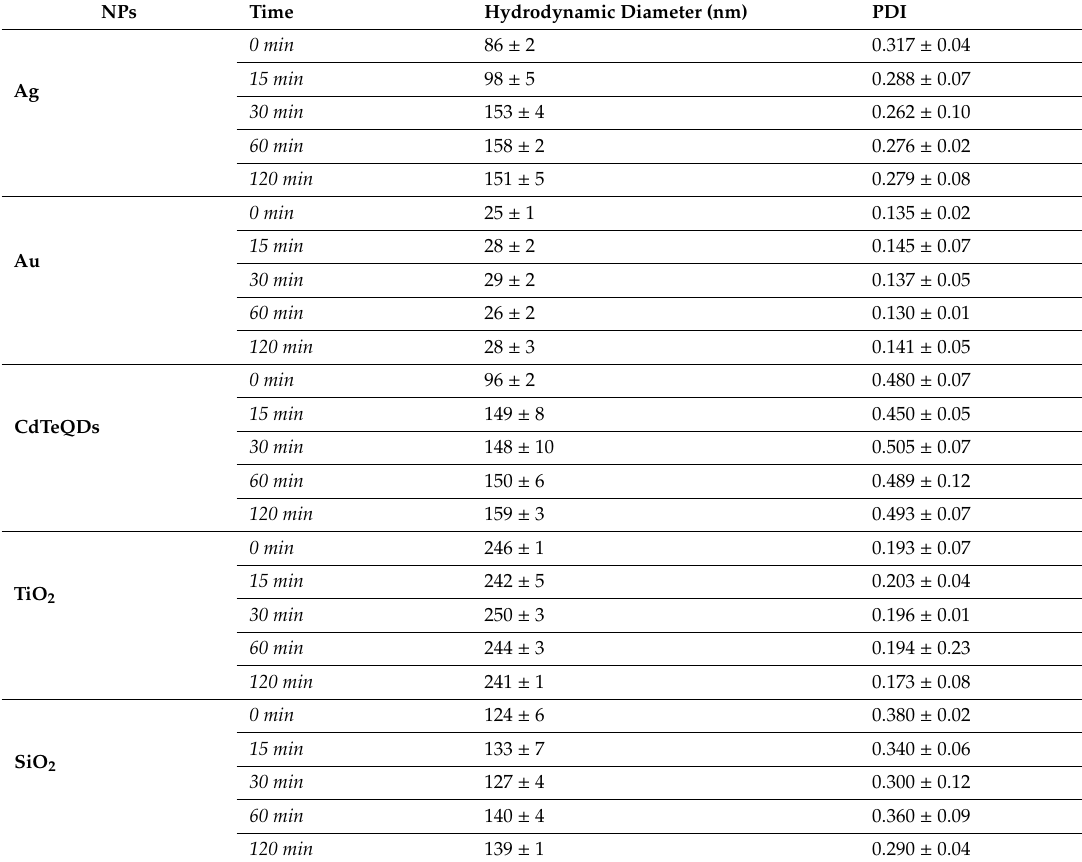
Table 2. Agglomeration of NPs